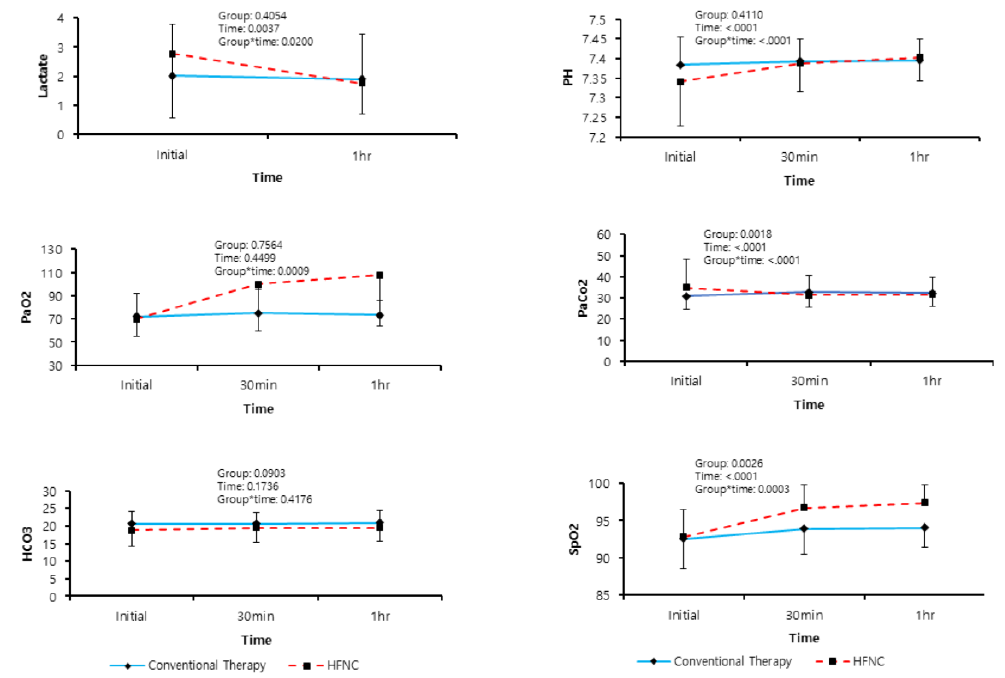
Figure 3. Linear mixed model of changes in arterial blood gas analysis parameters. The graphs show interaction e ff ects between time and treated group using linear mixed model (Group * Time), PaO 2 : partial pressure of oxygen, PaCO 2 : partial pressure of carbon dioxide, SpO 2 : peripheral oxygen saturation, HFNC: high-flow nasal cannula. Table 3. Post hoc analysis to estimate the time points at which the treatment e ff ects di ff ered between the 2